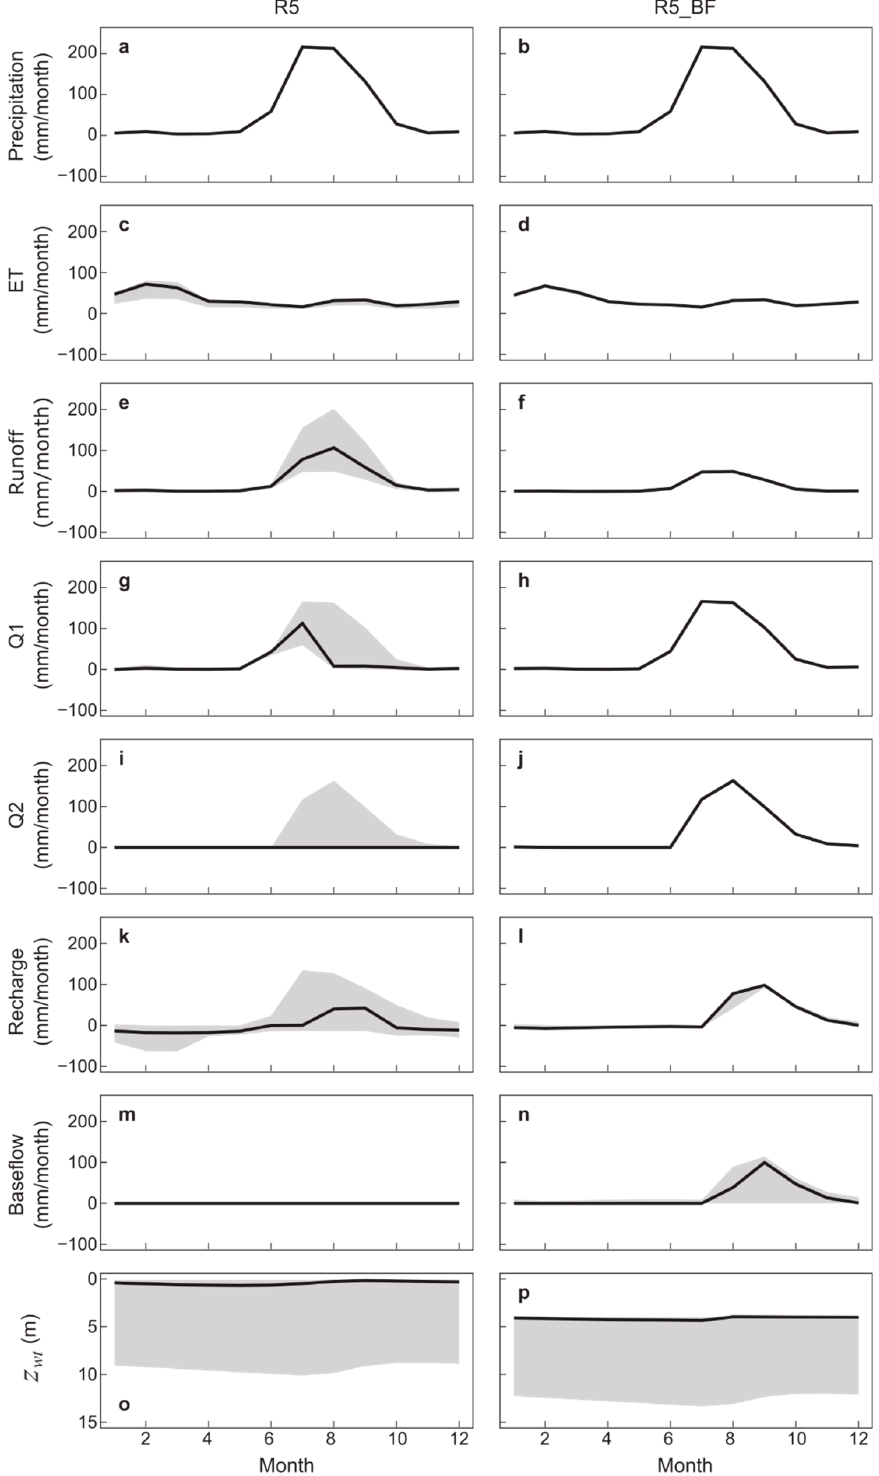
Figure 9. Time series of cell fluxes for: the R5 model in which all groundwater discharge occurs through interaction with the land surface, and the R5_BF model including groundwater head-dependent baseflow. Precipitation is that reaching the soil surface, Q1 is the flux between soil layers 1 and 2, Q2 is the flux between soil layers 2 and 3, baseflow is the river baseflow contribution for R5_BF. The solid line is the median of the model cell values and the shaded area is the range within the 10–90% tile.